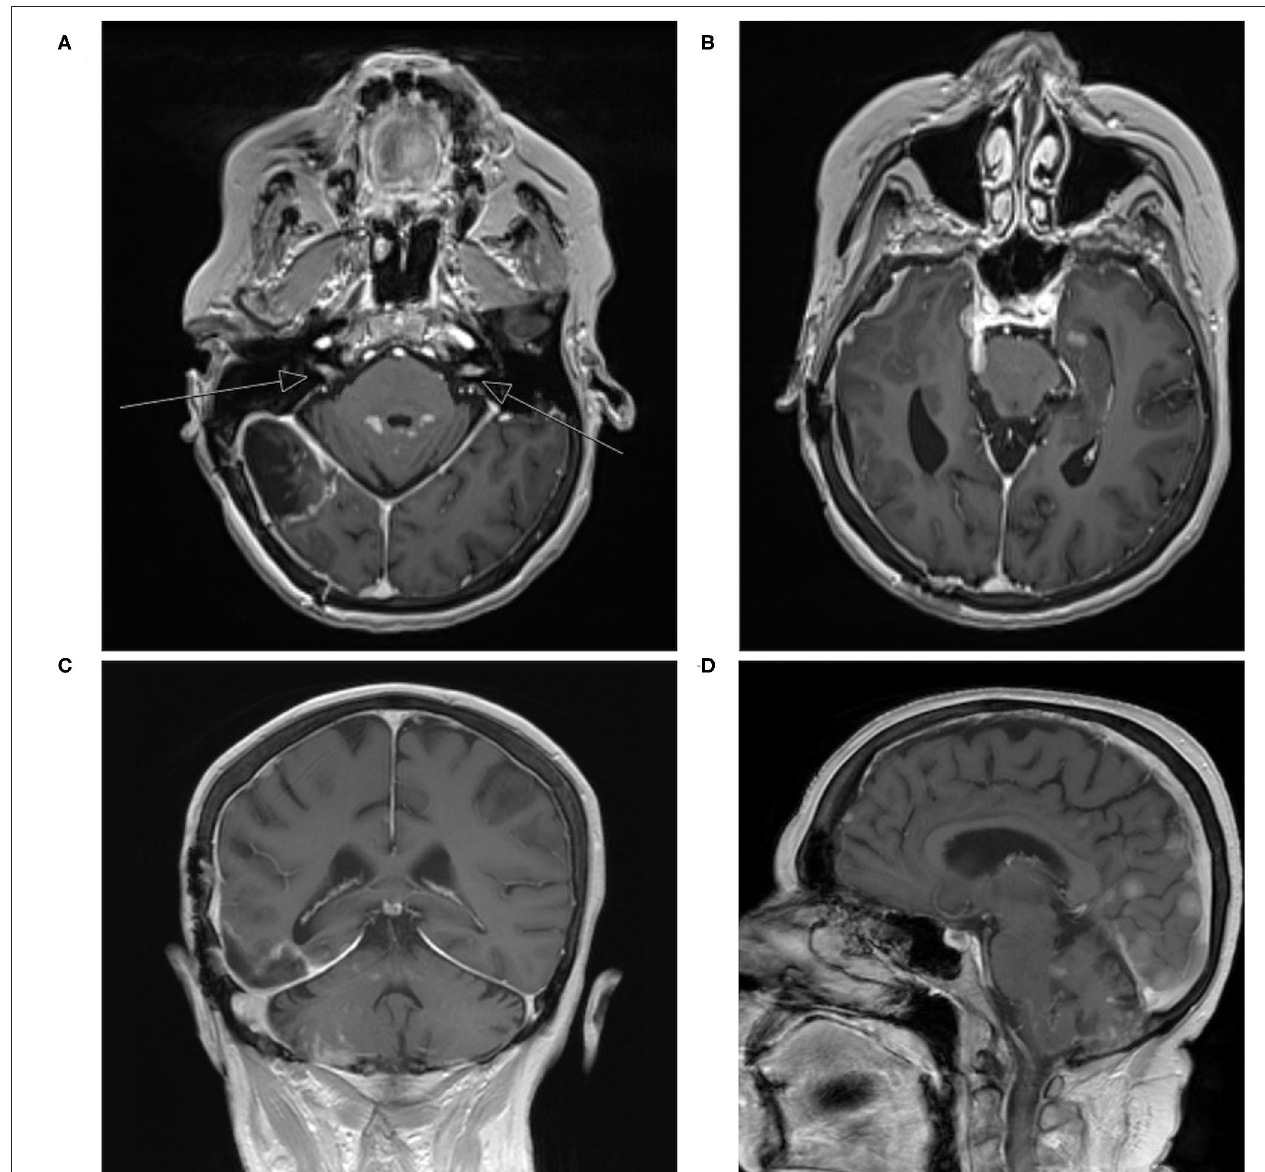
FIGURE 3 | (A–D) Repeat T1-weighted MRI with contrast three years later with interval development of extensive diffuse enhancing dural nodularity, numerous avidly enhancing supratentorial and infratentorial lesions, enhancement of the bilateral trigeminal nerves, internal auditory canals, and exit wound from the surgical site into the posterior aspect of the right-sided neck musculature consistent with diffuse leptomeningeal dissemination (arrows indicate internal auditory canals). 84% expired at the time of publication. The median